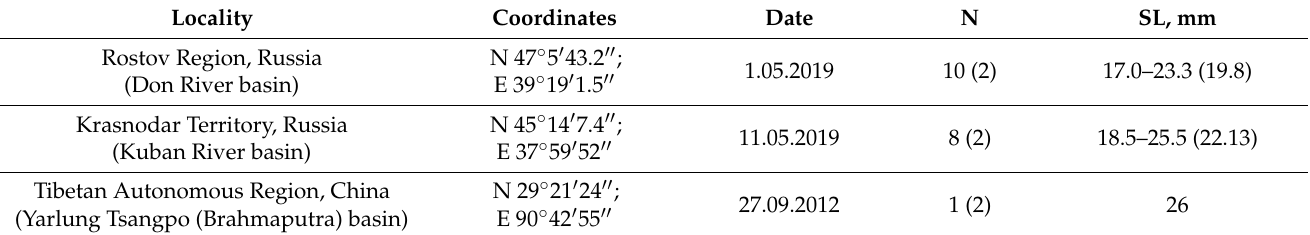
Table 1. Sampling localities of fish ( Oryzias sp.) with regards to information on regions: their coordinates (in geographical degrees); the number of measured fish individuals, N (the number of genotyped individuals is in parentheses); and their standard length SL, mm (means are in parentheses).